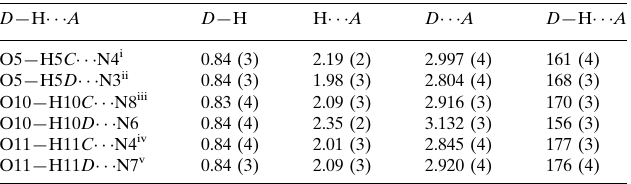
Hydrogen-bond geometry (A˚ , (cid:3)